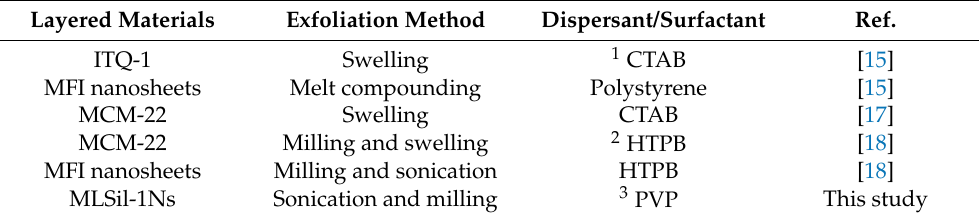
Table 2. List of reported exfoliated zeolite nanosheets methods.